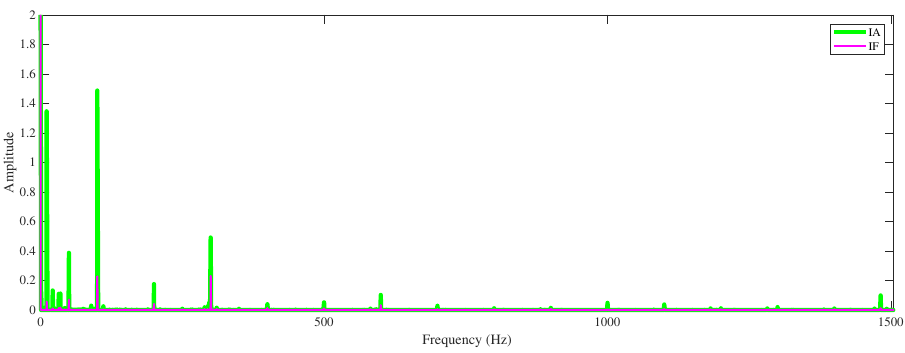
Figure 12. FFT of IA and IF for the measured